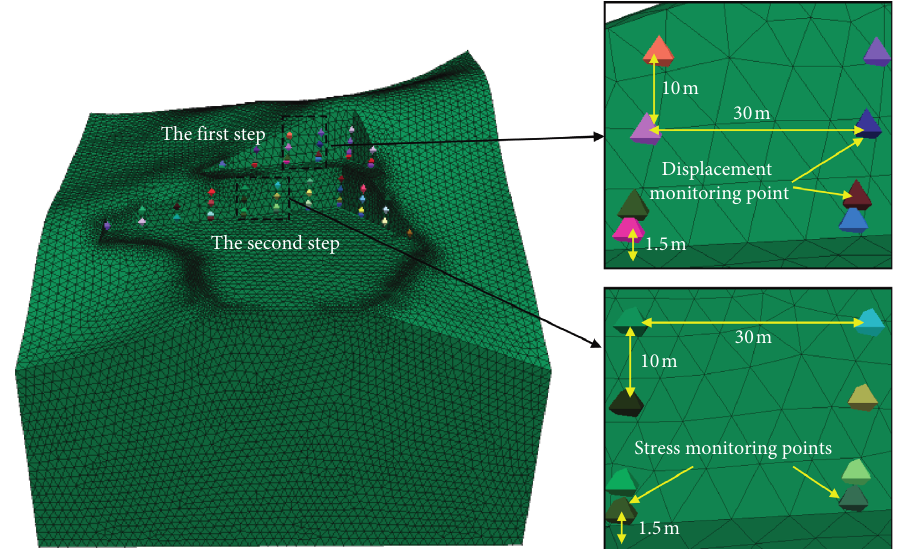
Figure 15: Arrangement of stress and strain monitoring